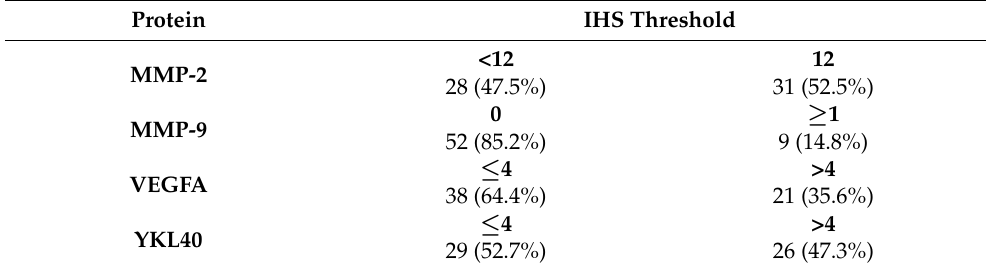
Table 5. Distribution of cases according to the IHS threshold value chosen for each